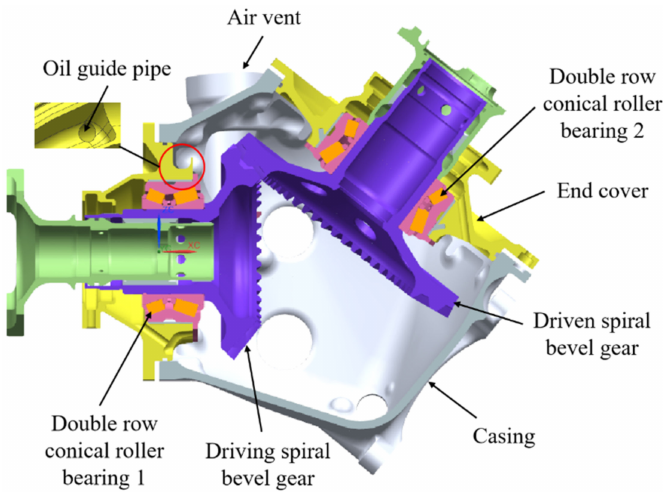
Figure 1. Schematic diagram of an intermediate gearbox.